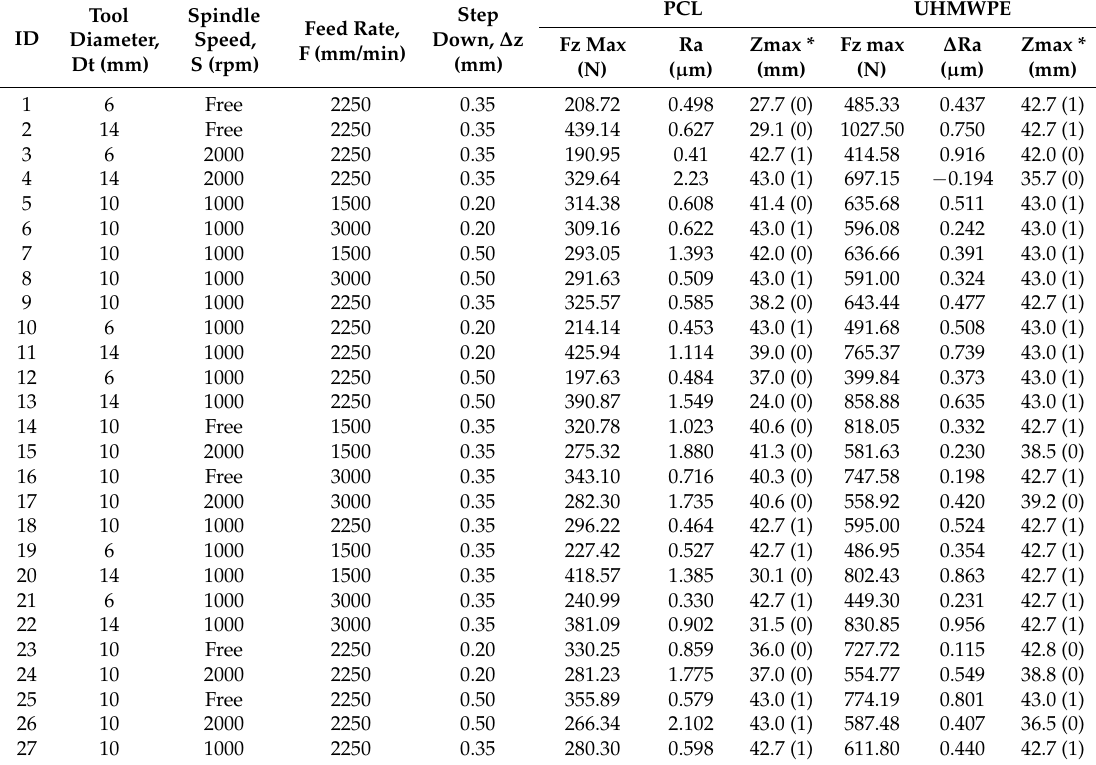
Table 2. Design of experiments and